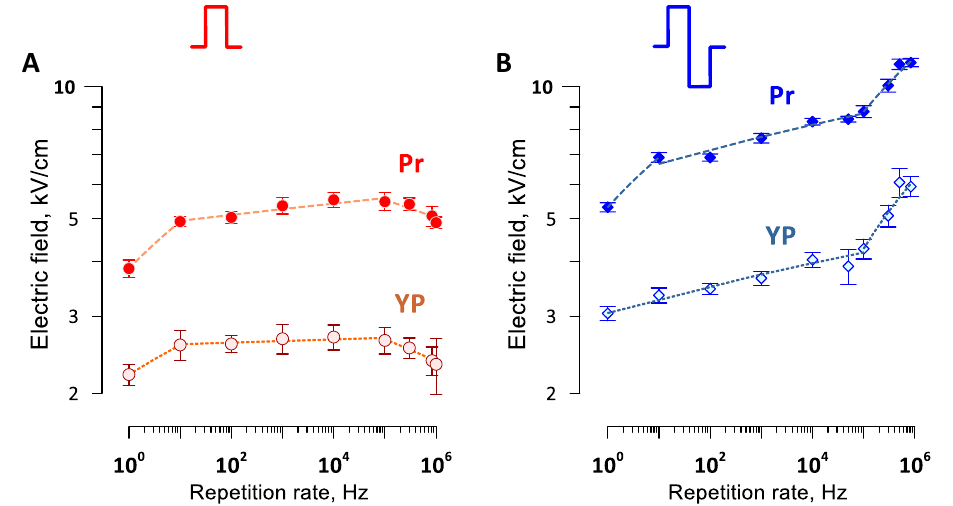
Figure 13. The effect of pulse repetition rate on the thresholds for electroporation (YP) and cell killing (Pr) by bursts of unipolar ( A ) and bipolar ( B ) pulses. Ten bursts of 10 pulses each were delivered at a constant rate of 1 Hz, while the repetition rate within the bursts was varied. At the lowest rate shown (10 0 Hz), pulses were delivered as a single 100-pulse train. Pulse duration ( A ) and single phase duration ( B ) was 600 ns. Dashed lines are best fits using power function. Electroporation thresholds were measured from the borders of YO-PRO-1 (YP) dye uptake; the dye was added before the pulse treatment and removed 30 min after it. Electric field thresholds for cell death were measured from the borders of propidium (Pr) staining when the dye was added 2 h after the pulse treatment. See text for more